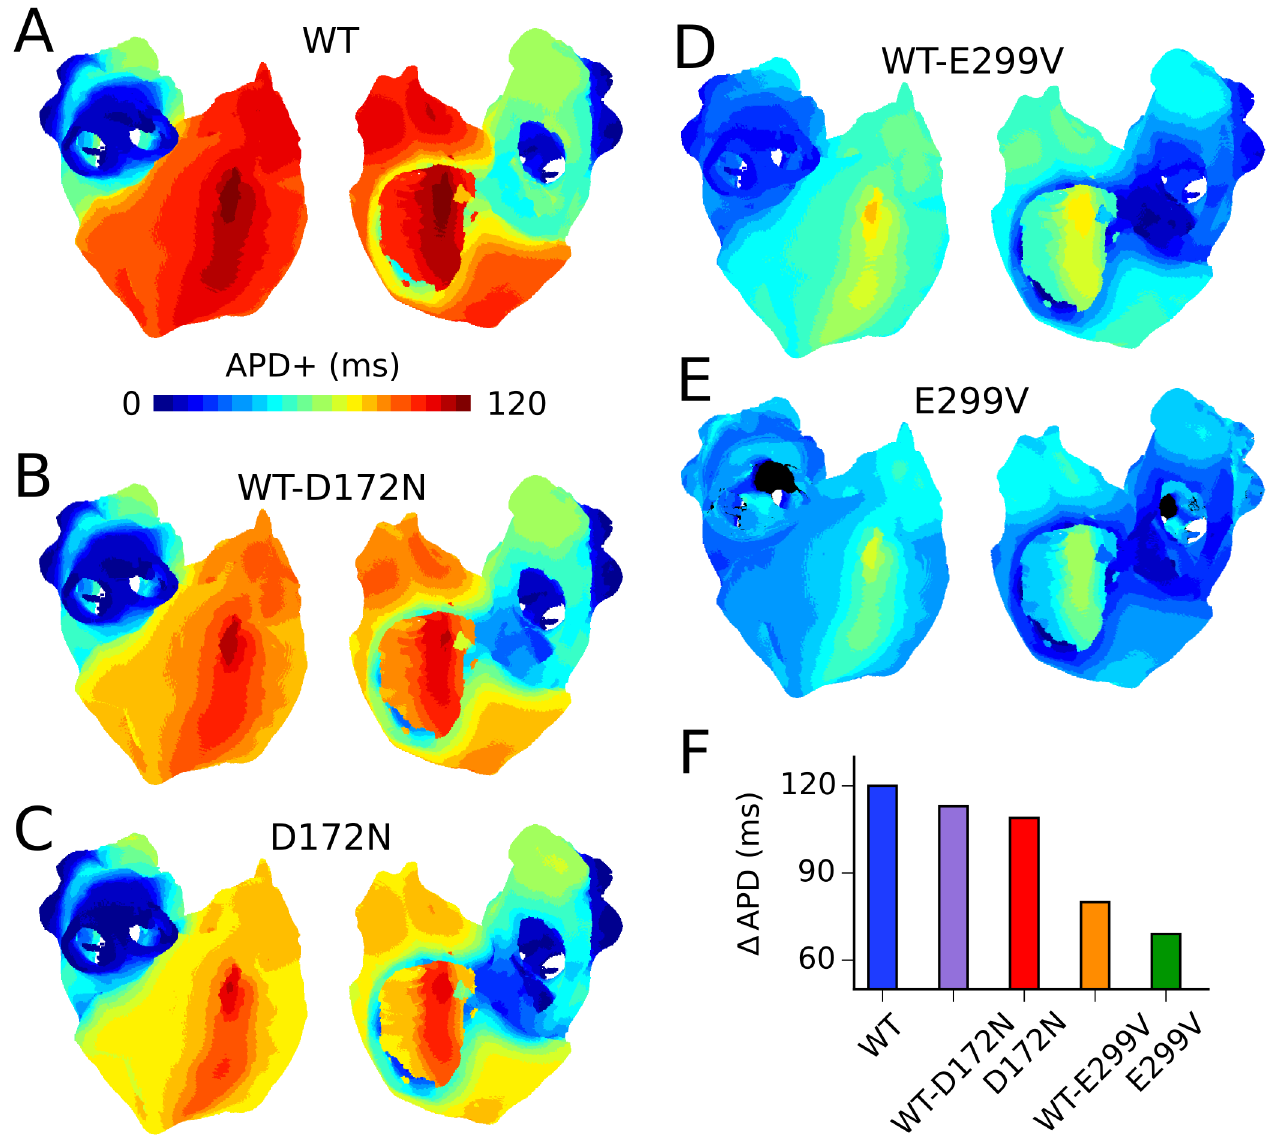
Fig 4. Spatial dispersion of APD in 3D anatomical atria model. APD distributionmaps in WT (A), WT-D172N (B), D172N (C), WT-E299V (D), and E299V (E) mutation conditions, with corresponding global Δ APD (F). The colourbar shows APD relativeto the shortest APD measuredin each condition, designated APD+. The scale of the colourbar is fixed at the value of Δ APD in the WT condition(120 ms) to facilitate comparison betweenthe mutation conditions. The colour black shows regions where membranepotentials failed to exceed a threshold value ( −